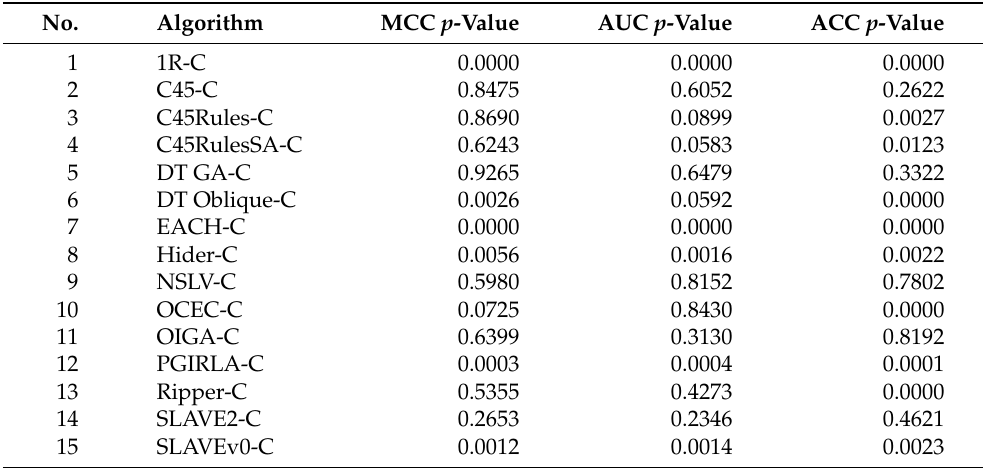
Table 5. Comparison of fuzzy rule-based classifiers and GPR with Wilcoxon’s signed-rank